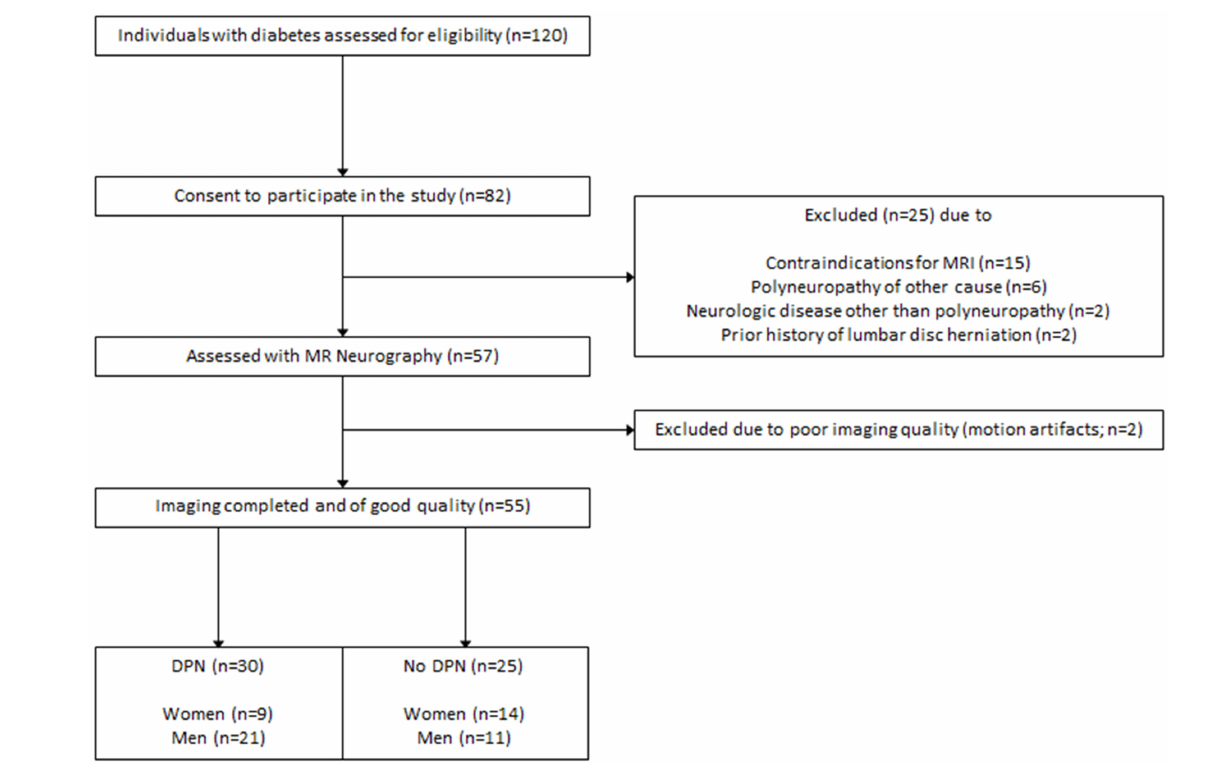
FIGURE 1 | Process of patient recruitment and data